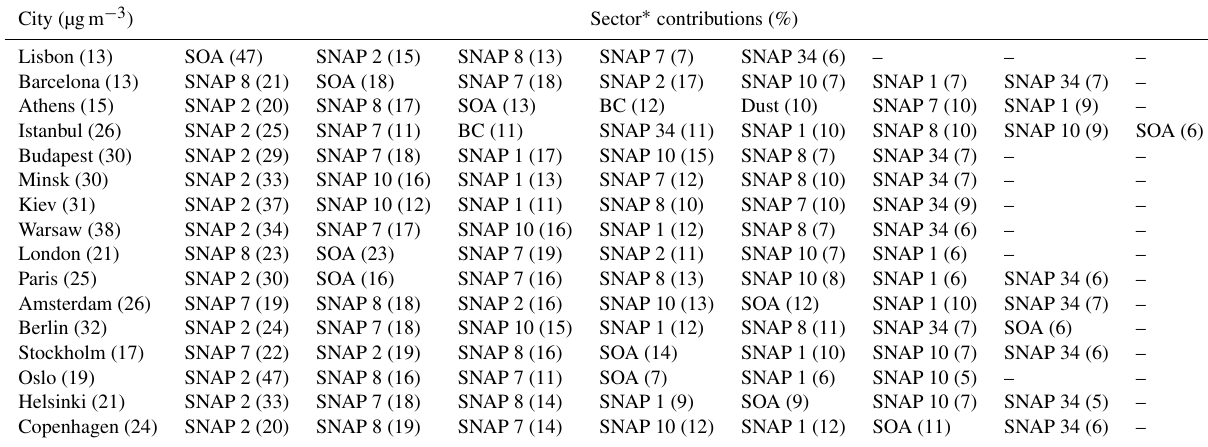
Table 8. Sectors contributing 5% or more to wintertime monthly mean PM 2 . 5 concentrations. Sector contributions in percentages are shown in